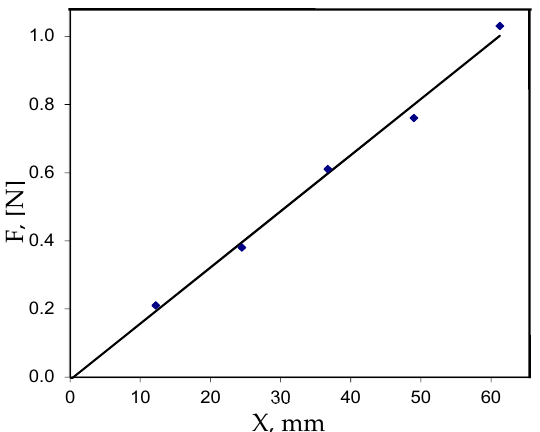
Figure 10. Dependence of the displacement X on the load F at the end of the rod for the rigid–rigid connection and rod length of 610 mm ( L / R = 2).